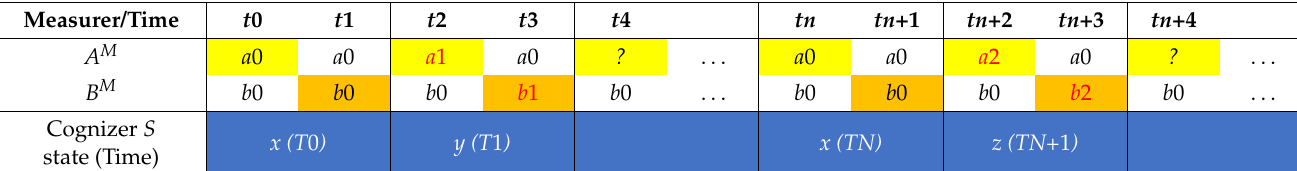
Table 1. A focal cognizer S is composed of two measurer cognizers, A M and B M . In addition, a 0 and b 0 are baseline states for the measurers A M and B M , respectively. Each state of S , such as x and y , includes a cognition by the measurers. One-to-many changes are highlighted with red symbols, such as a 0 → a 1 or a 2. The measurers change their states on a fine-grained timescale, t0, t1, t2, . . . , tn, tn+1, tn+2. The cognizer changes its states on a coarse-grained timescale, T0, T1, . . . , T N , T N +1.